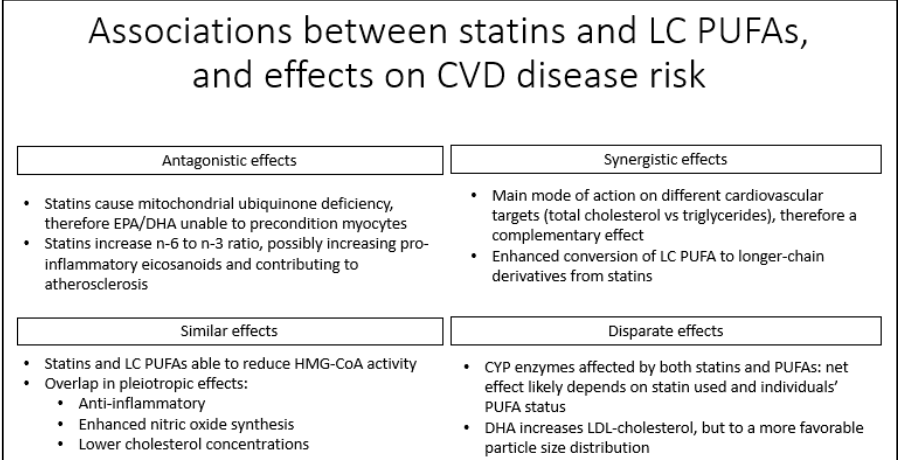
Figure 2. Overview of the interaction between statins and n -3 LC PUFAs on cardiovascular risk factor.